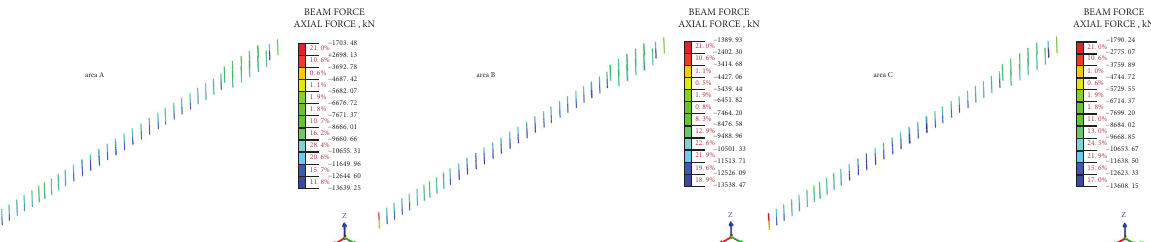
Figure 12: Axial diagram of the station column from the foundation pit excavation to the pit bottom in each